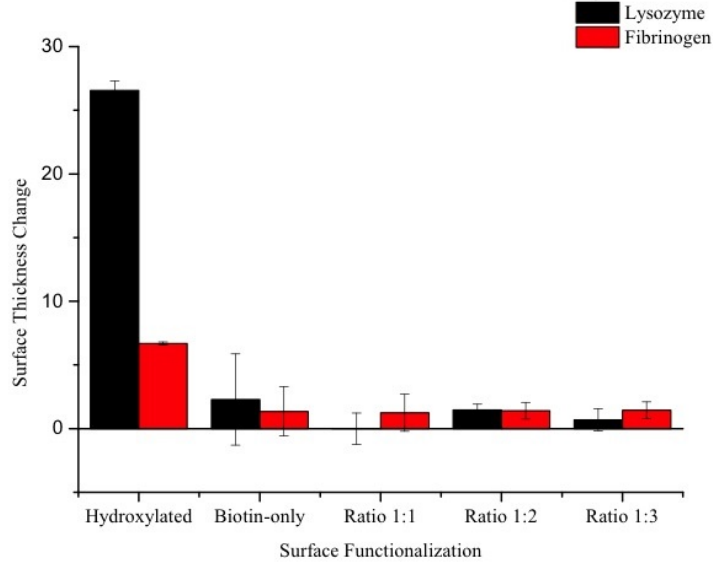
Figure 8. Mean thickness change (±standard deviation, nm) of functionalized wafers after adsorption. Three spots were measured on each wafer with ellipsometry, and three wafers were examined for each group. The values correspond to the amount of non-specific protein adsorbed onto the functionalized wafers.